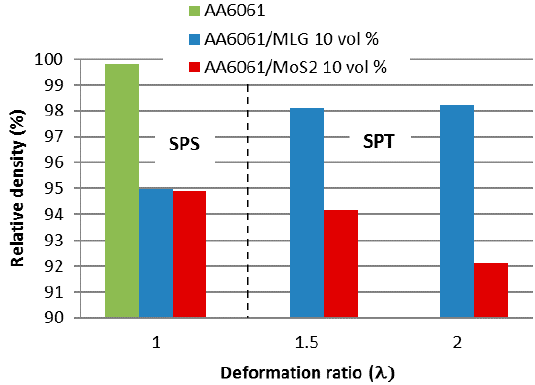
Figure 5. Influence of SPS and SPT processing conditions on the relative density of AA6061 matrix composites.